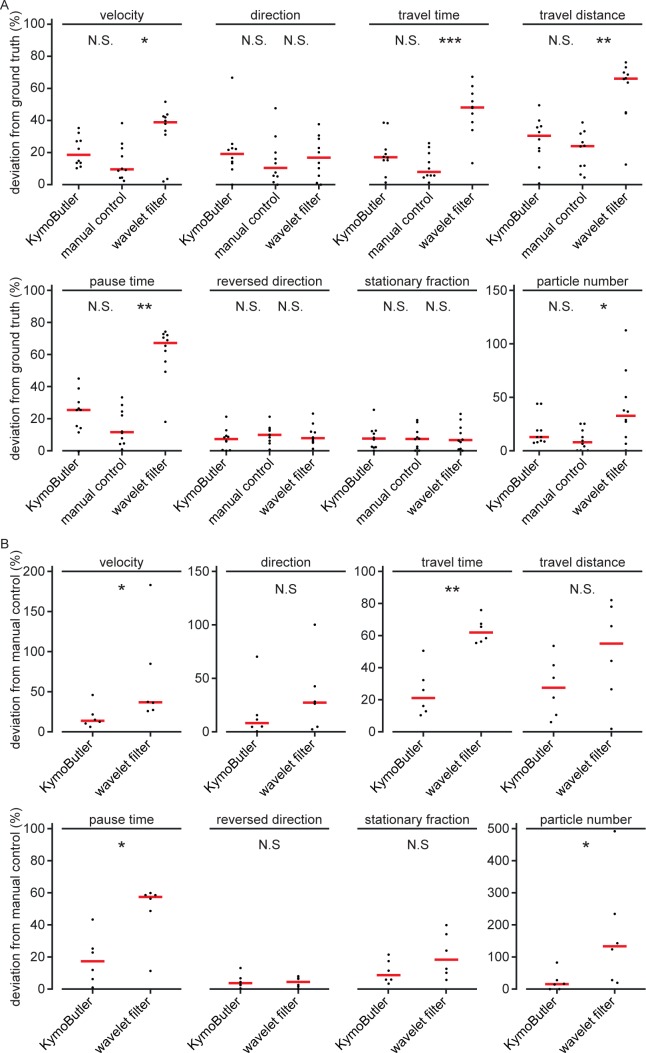
Synthetic data quantities derived from bidirectional kymographs using manual annotation, KymoButler, and wavelet filtering for simulated and real data.(A) Deviation from the average ground truth values per synthetic kymograph for all three different analysis approaches (velocity: p=0.03, Kruskal-Wallis Test, Tukey post-hoc: manual vs KymoButler p=0.5, manual vs Wavelet Filtering p=0.02; orientation: p=0.6; travel time: p=5⋅10-4, manual vs KymoButler p=0.6, manual vs Wavelet Filtering p=5⋅10-4; travel distance: p=8⋅10-4, manual vs KymoButler p=0.7, manual Wavelet Filtering p=1⋅10-3; pause time: p=2⋅10-3, manual vs KymoButler p=0.5, manual Wavelet Filtering p=2⋅10-3; percentage of tracks that change direction at least once: p=0.5; percentage of stationary tracks: p=1; particle number: p=0.04, manual vs KymoButler p=0.4, manual vs Wavelet Filtering p=0.03). (B) Deviation from manually obtained average values per real kymograph from our validation set (velocity: p=0.03, Wilcoxon ranksum test; orientation: p=0.4; travel time: p=0.02; travel distance: p=0.2; pause times: p=0.03; percentage of tracks that change direction at least once: p=0.9; percentage of stationary tracks per kymograph: p=0.24; particle number per kymograph: p=0.02).